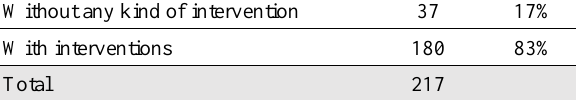
Table 8. State of intervention of studied buildings.